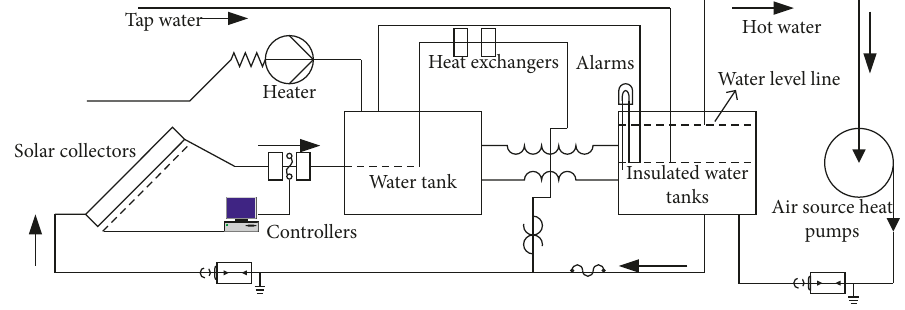
Figure 3: Control flow of the solar water heating system assisted with an air source heat